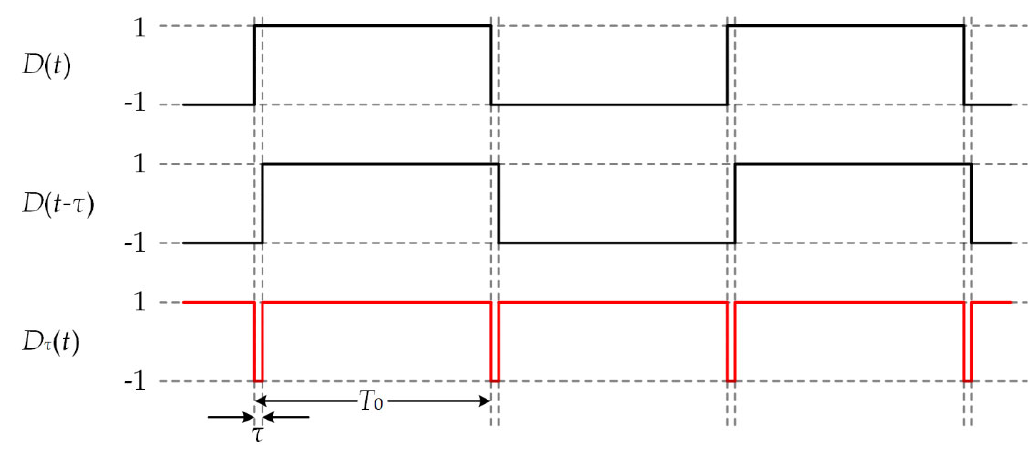
Figure 1. The bit sign transitions are eliminated by delay and multiplication (DAM) operation